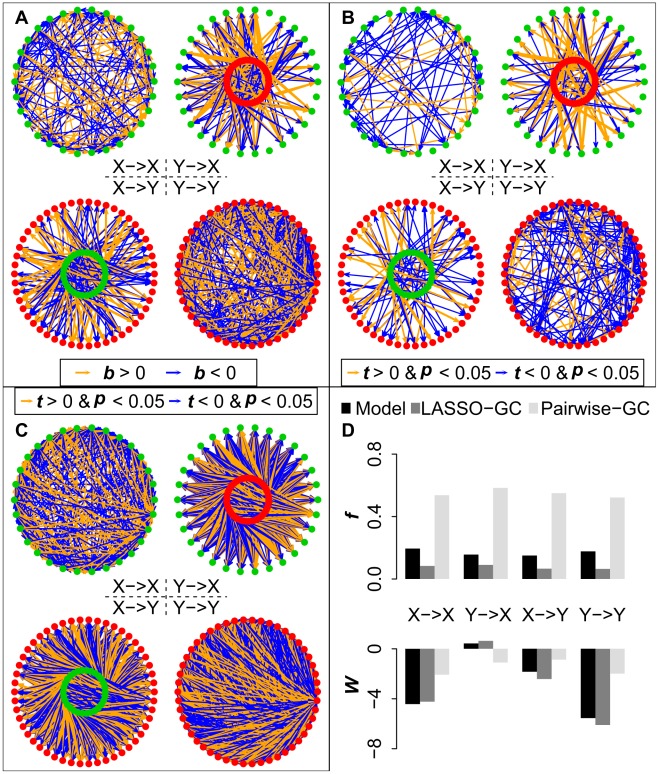
Comparison of model estimation by LASSO-GC and pairwise-GC methods for one simulation model.The X voxels in A-C are represented by green dots and Y voxels by red dots. All the t and b values are z-normalized. A) Simulated connectivity pattern of the model for the four B matrices, with orange arrows representing positive b values and blue arrows negative b values. B) Estimated connectivity pattern with LASSO-GC method. Significant t-scores are shown as arrows, with the thickness representing the absolute magnitude of the t-scores, and the color representing the sign of the t-score (orange for positive, blue for negative). The pattern is similar to that in the model. C) Estimated connectivity pattern with pairwise-GC method, shown in the same manner as for the LASSO-GC result. The connectivity is much denser than the model pattern. D) Summary statistics f and W for the patterns shown in the previous three panels. LASSO-GC values match the model values more closely than do pairwise-GC values.